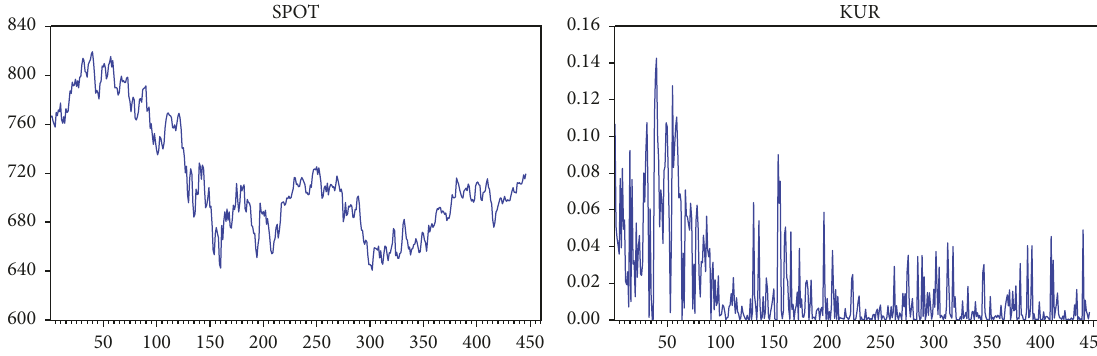
Figure 8: Extreme risk fear and index evolution in 2012-2013.